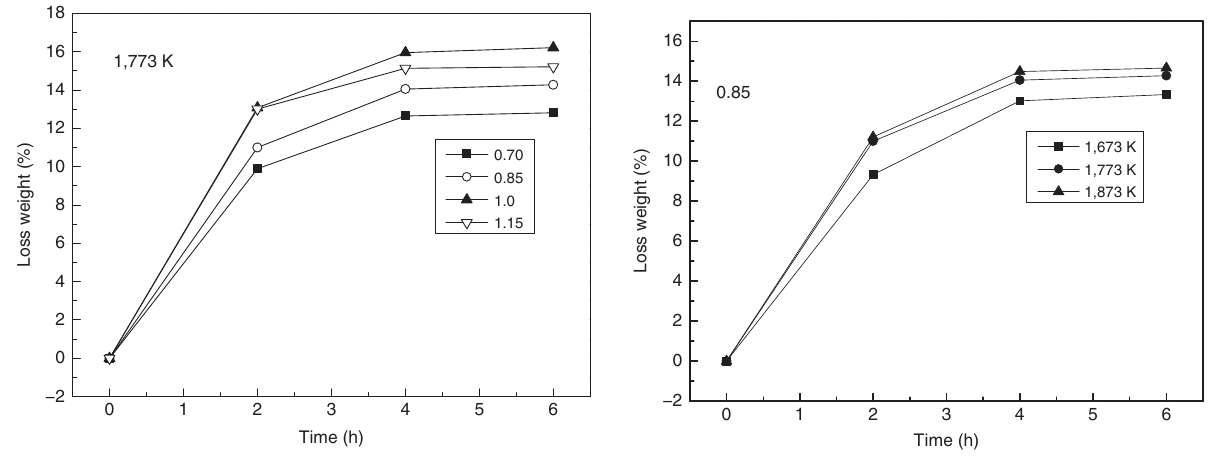
Figure 7: The percentage of total mass loss with carbon ratio of 0.85 at different